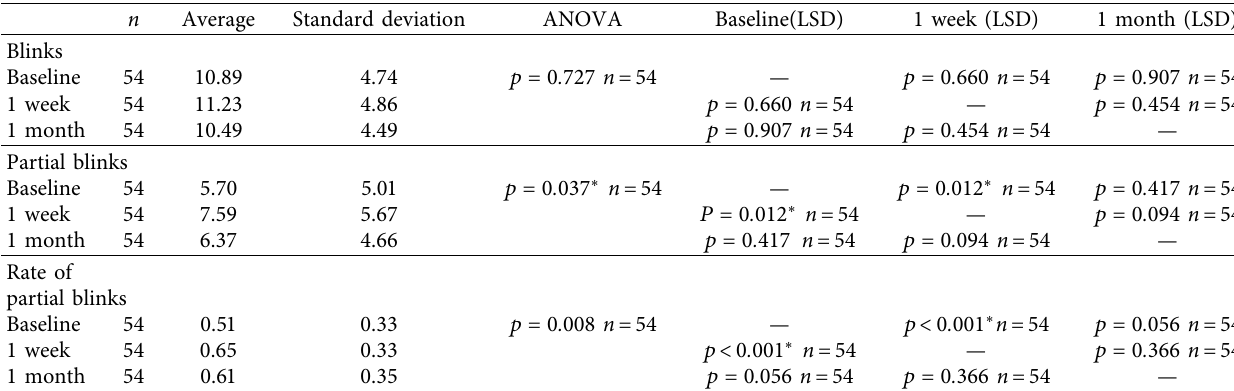
Figure 2: Lipid layer thickness (average, minimum and max) after orthokeratology lens wear. The average lipid layer thickness (average, minimum, and max) of the 56 patients at baseline, 1 week, and 1 month after orthokeratology treatment. ∗ denotes p < 0 . 05. Table 6: Short-term change of blinking pattern after